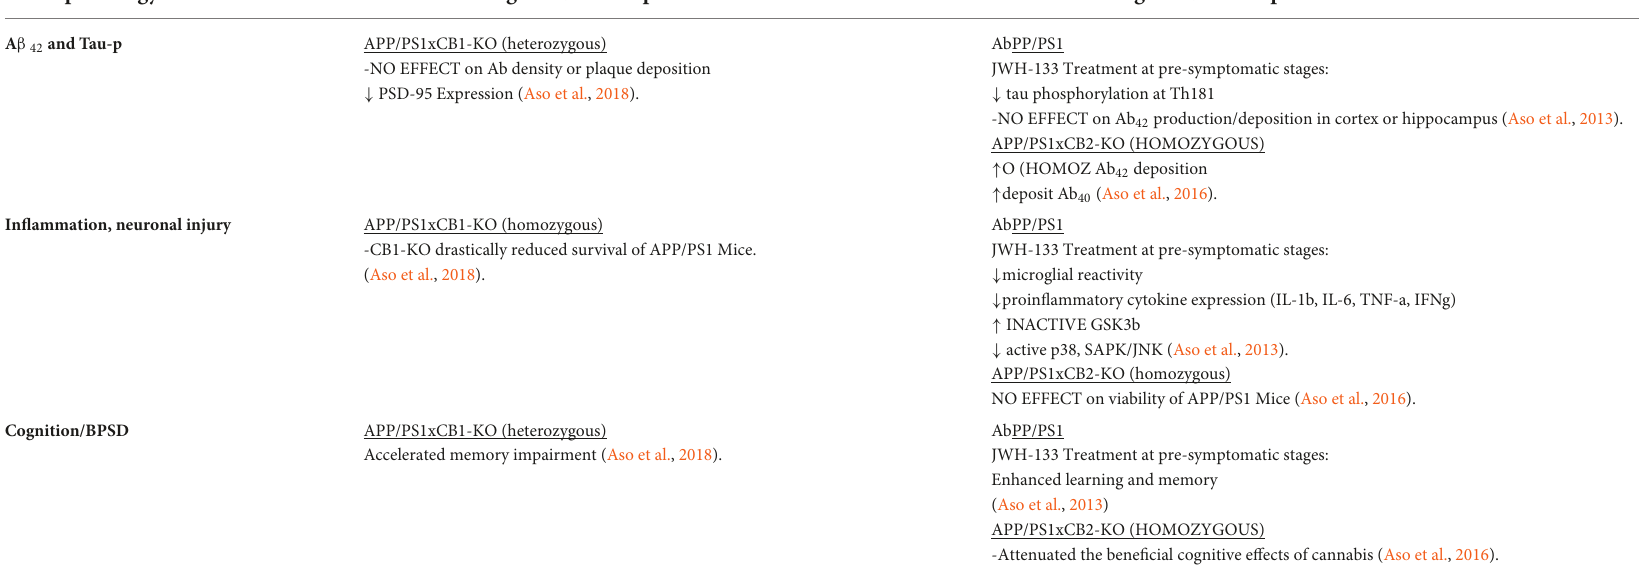
TABLE 4 Distinct contributions of CB1R or CB2R on stress and neuropathology in AD transgenic rodent